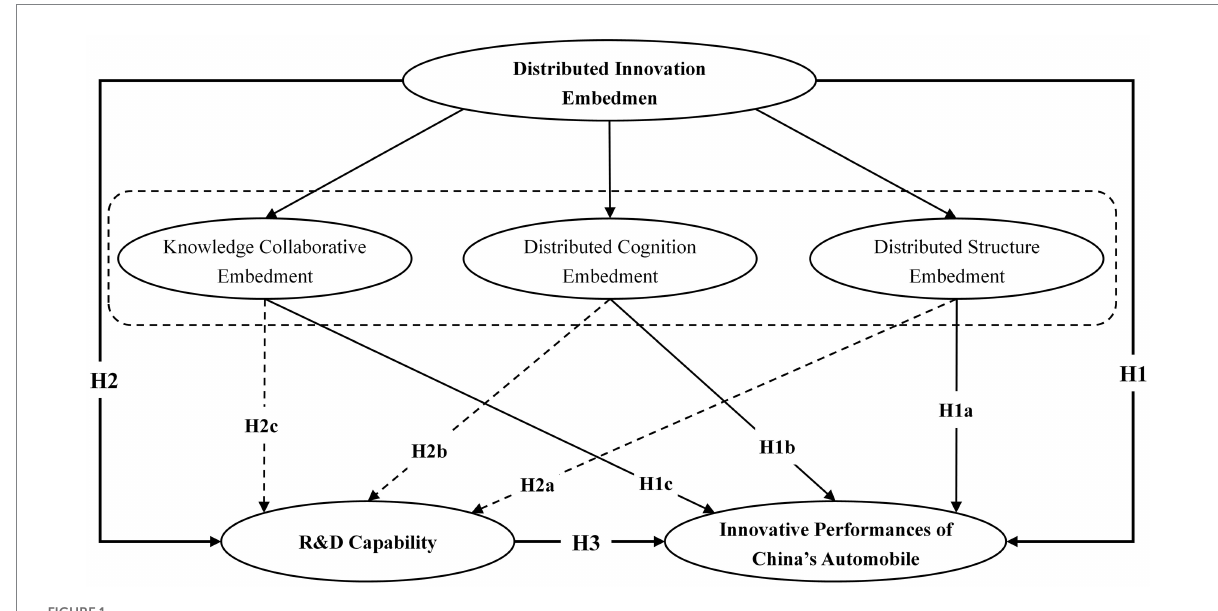
FIGURE 1 Proposed